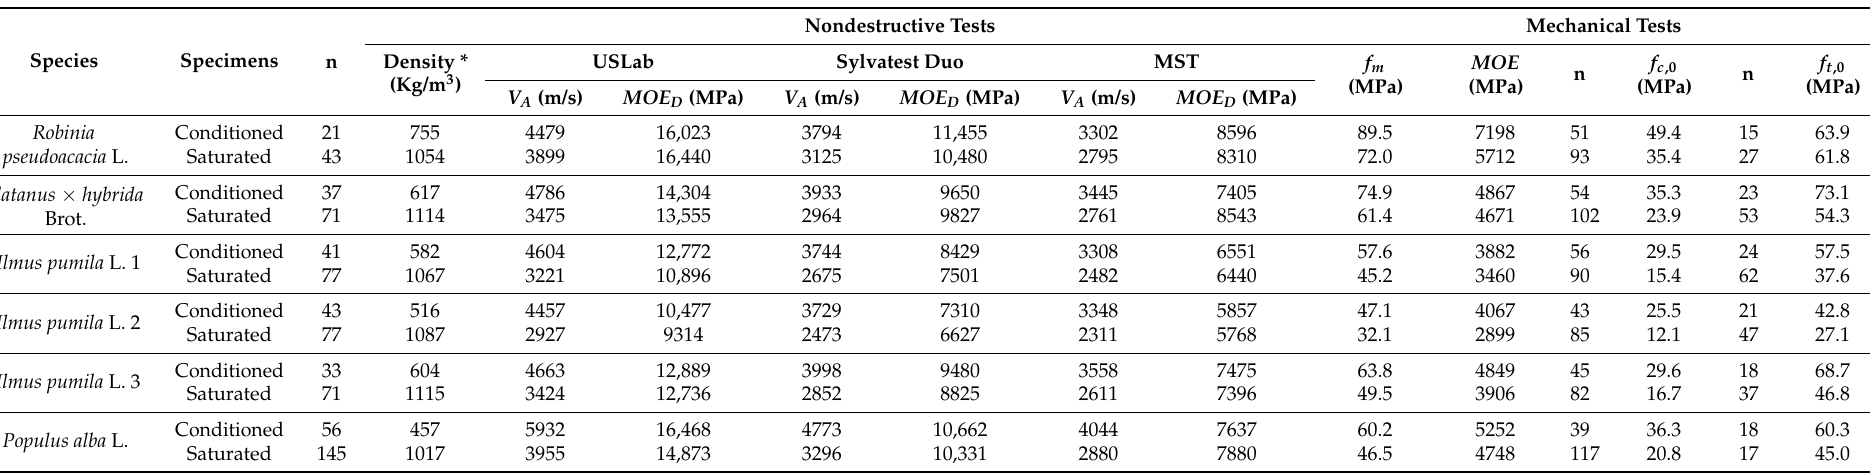
Table 4. Average velocities ( V A ), dynamic and static modulus of elasticity ( MOE D ), bending strength, compression, and tension in conditioned and saturated